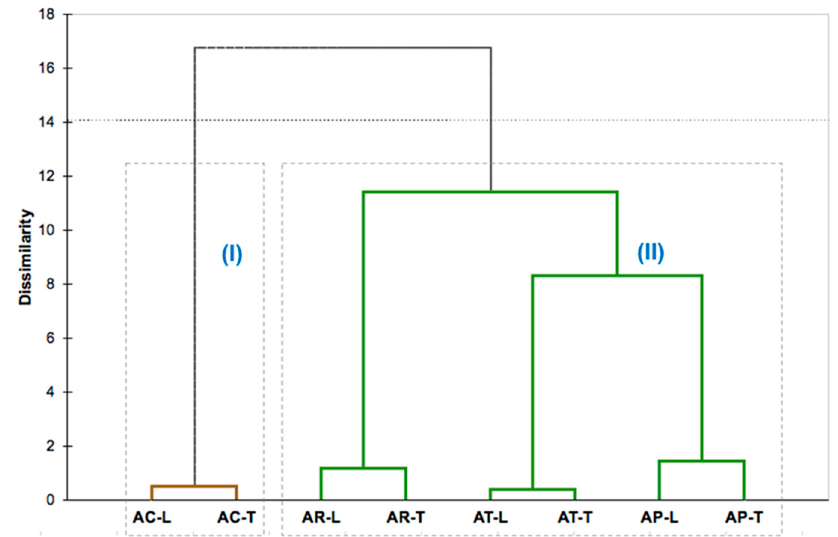
Figure 2. Hierarchical clusters analysis (HCA) obtained by Ward linkage method to Aniba species based on compound class present in their essential oil: AC ( A. canelilla ), AP ( A. parviflora ), AR ( A. rosaeodora ), AT ( A. terminalis ), L (leaves), T (twigs).